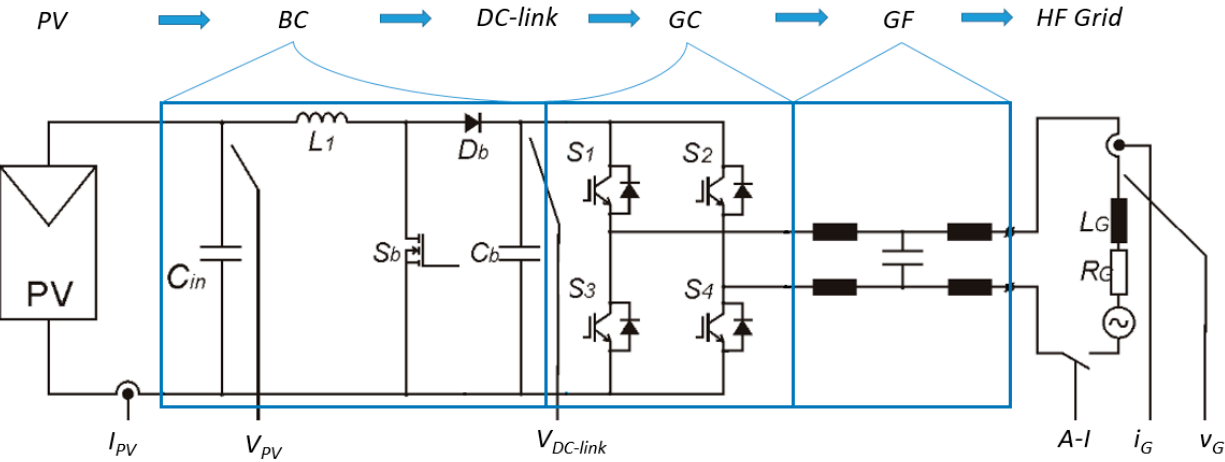
Figure 2. The power electronics coupling system: PV —photovoltaic source, BC —boost converter, GC —grid-tied inverter, GF —grid low-pass filter, HF Grid —high frequency on-board grid.